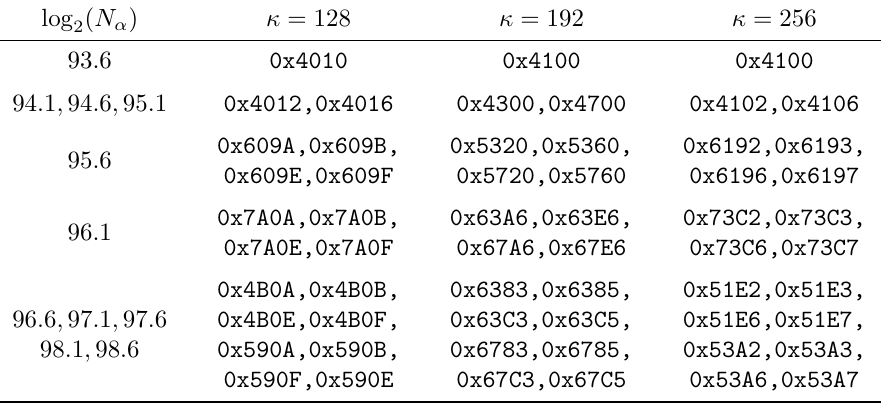
Table 8: Key differences used in basic related-key attacks on